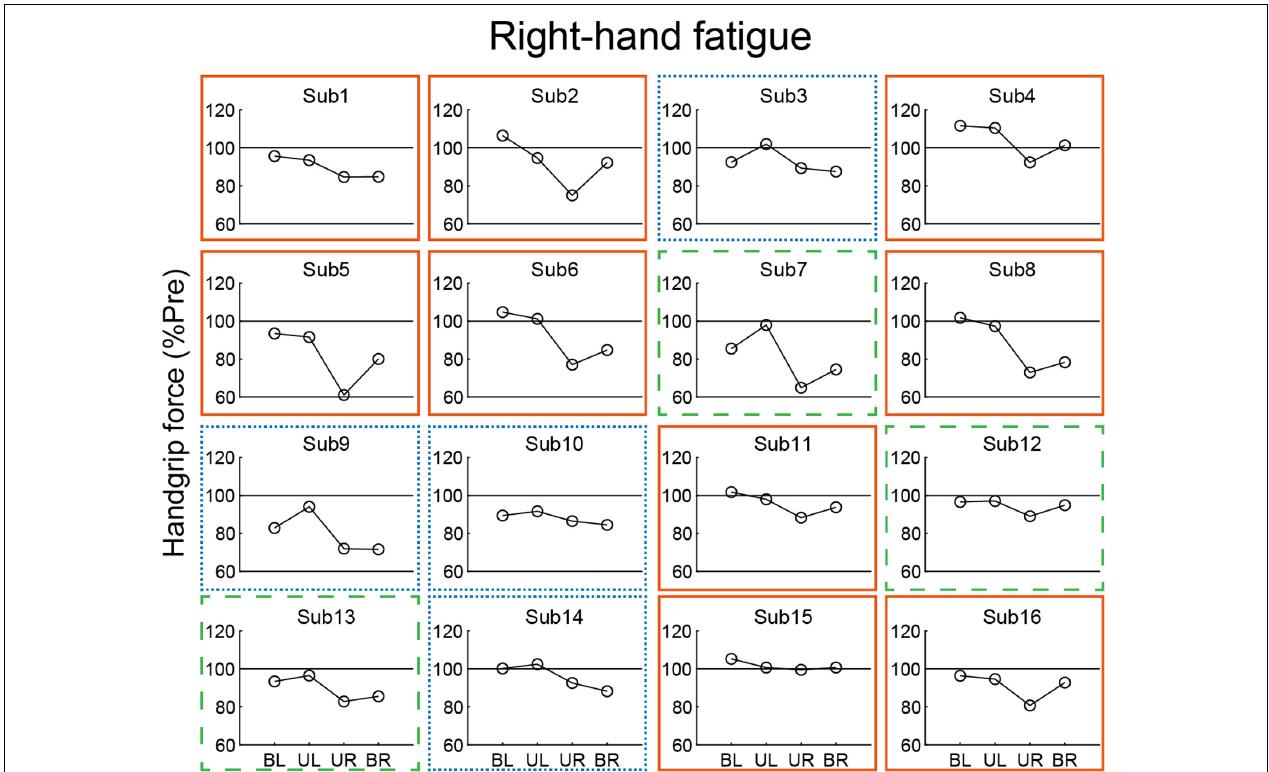
FIGURE 6 | Individual data from post-test handgrip force normalized by a pre-test in the right-hand fatigue condition. Nine subjects showed greater bimanual left (BL) and right (BR) handgrip force compared with unimanual left (UL) and right (UR) performance (orange solid rectangle). Three subjects exhibited greater BR handgrip force than UR performance but lower BL handgrip force than UL performance (green dashed rectangle). Four subjects showed a pattern in which BL and BR handgrip force were reduced more than UL and UR performance (blue dotted rectangle).